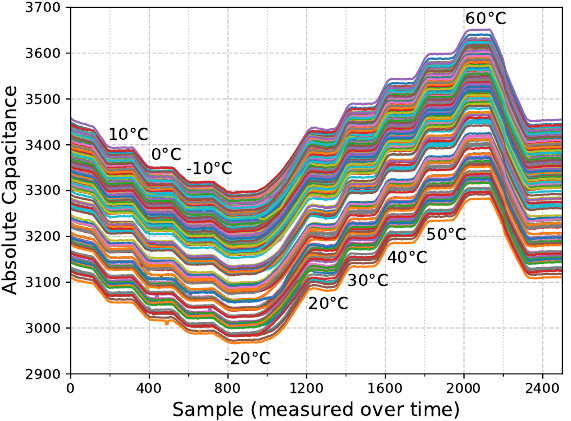
Figure 4: Absolute capacitance under temperature change. Data taken from [ION +